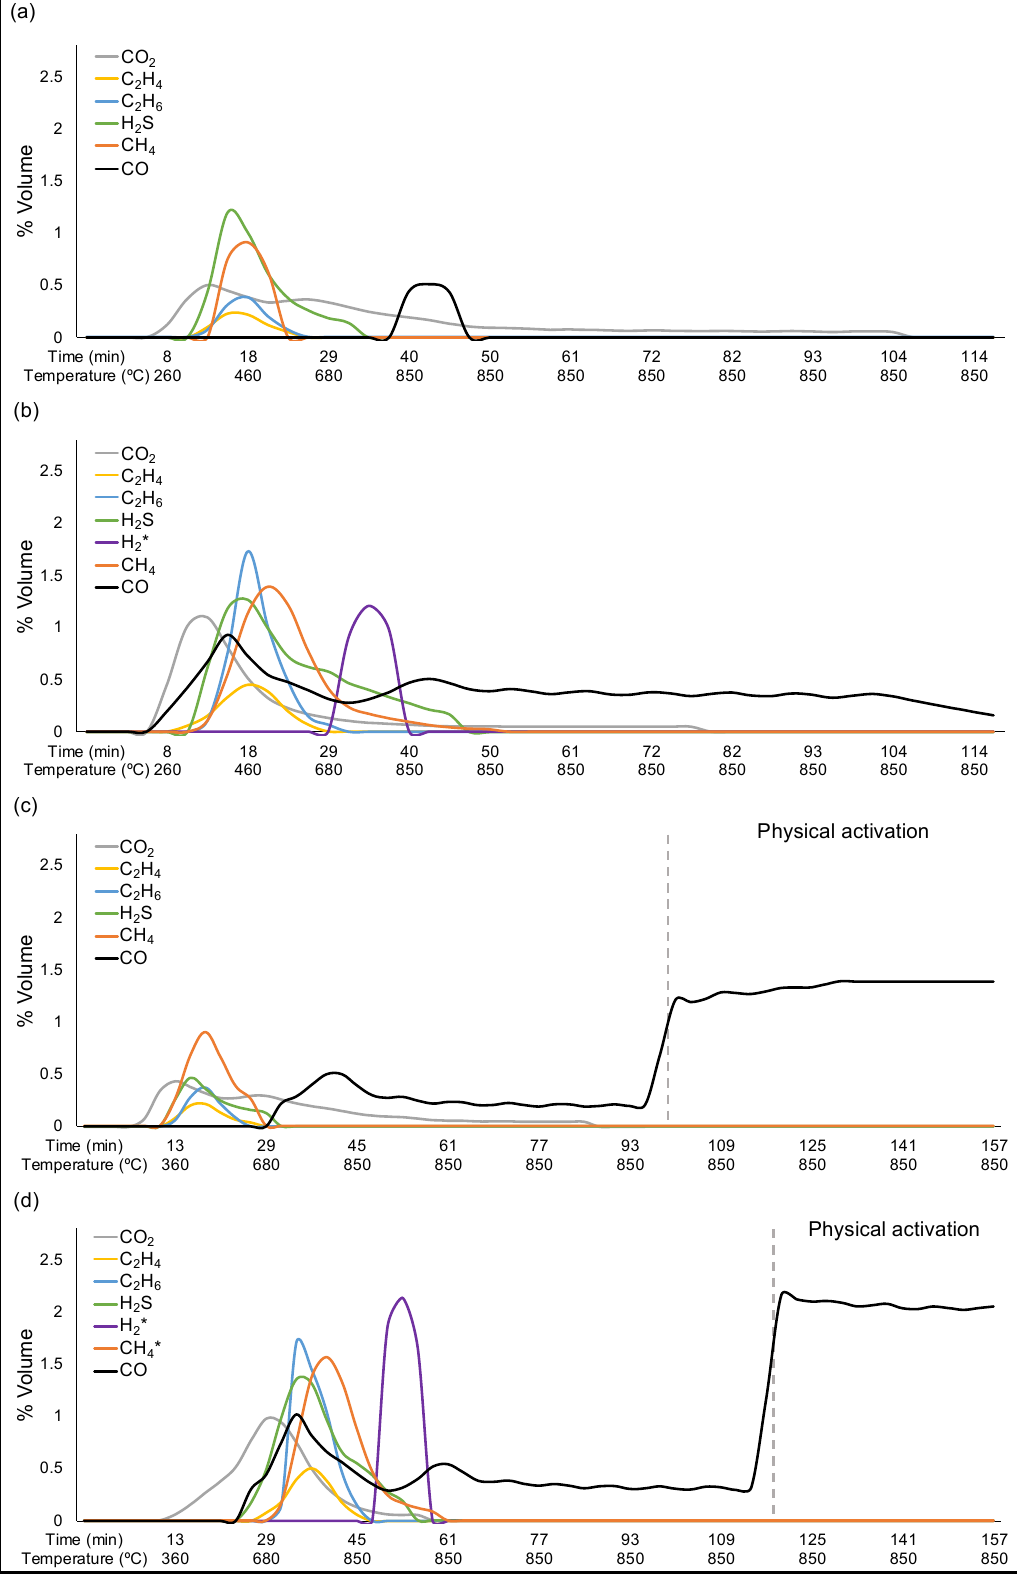
Figure 9. Composition of the evolved gas with respect to time/temperature from ( a ) G1, ( b ) G2, ( c ) G3, and ( d ) G4. Notes: H 2 and CH 4 concentrations in ( b ) and ( d ) were divided by four for comparison purposes with values obtained in ( a ) and ( c ); the remaining % in volume corresponds to injected gases (N 2 and CO 2 ).